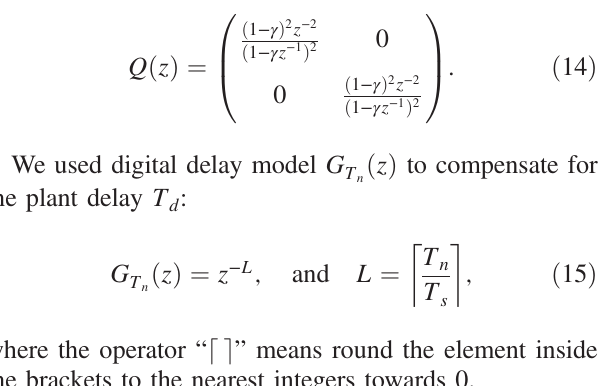
TABLE III. Transfer function of the Q Q filter Transfer function